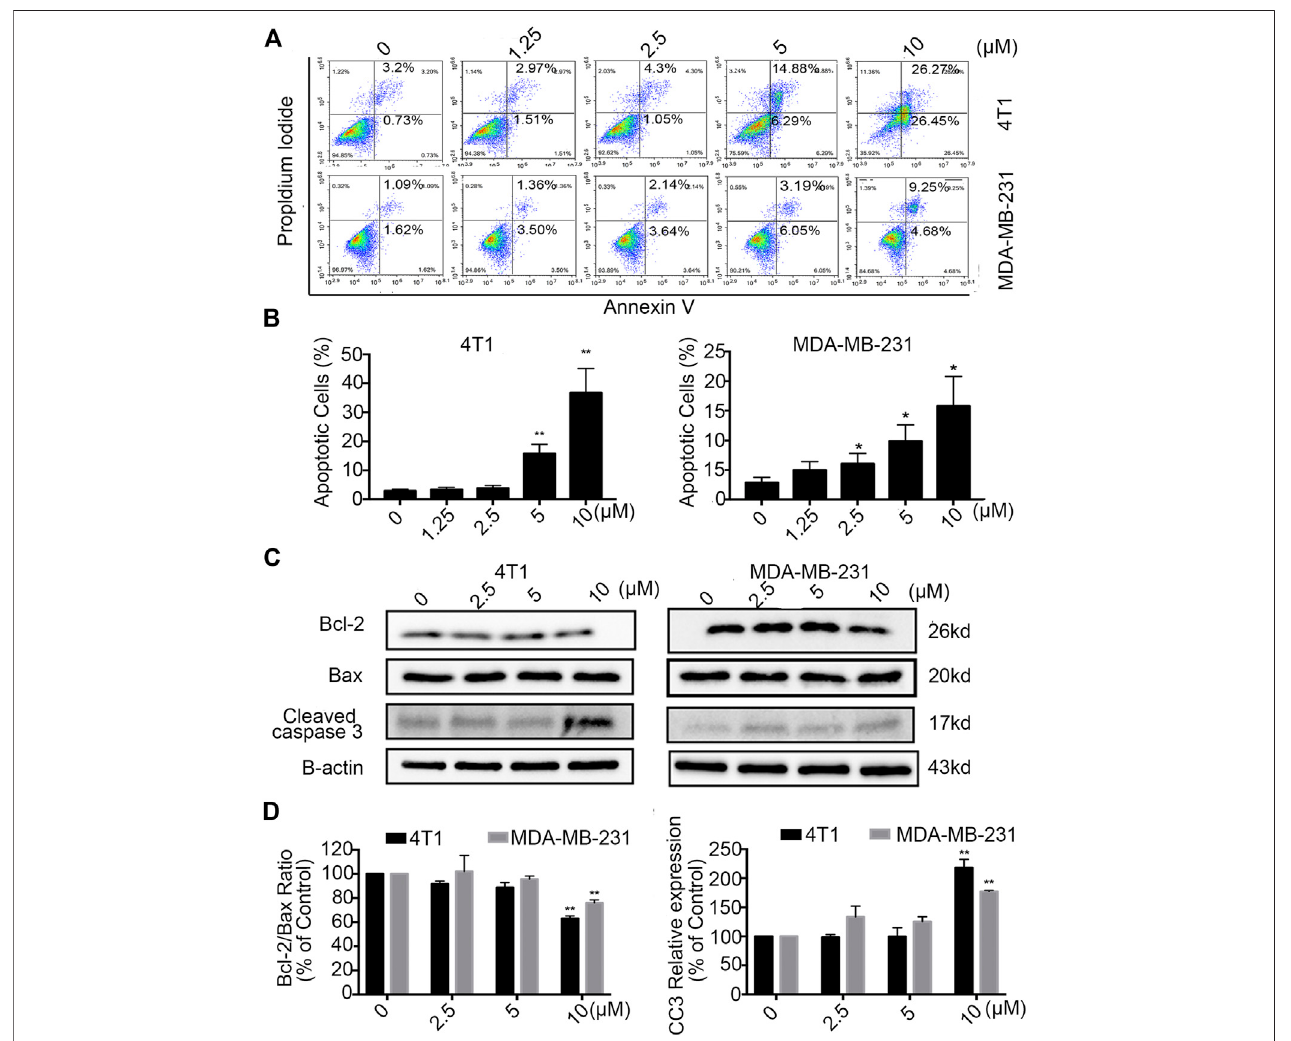
FIGURE 4 | Statmp-151 induced apoptosis in breast cancer cells. (A) 4T1 and MDA-MB-231 cells were treated with different concentrations of Statmp-151 for 24 hand then analyzed by FCM usingAnnexin V/PIdual staining. (B)The apoptosis dataanalysisispresentedin ahistogram. (C) Aftertreated withStatmp-151for 24 h in4T1andMDA-MB-231 cells,theexpressionsofcleavedcaspase-3,Bcl-2 andBaxwereobtained,with β -actinusedasastandardcontrol.( D )Thegray levelstatistics were quanti fi ed with ImageJ (* p < 0.05, ** p < 0.01 and *** p < 0.001 vs. the control